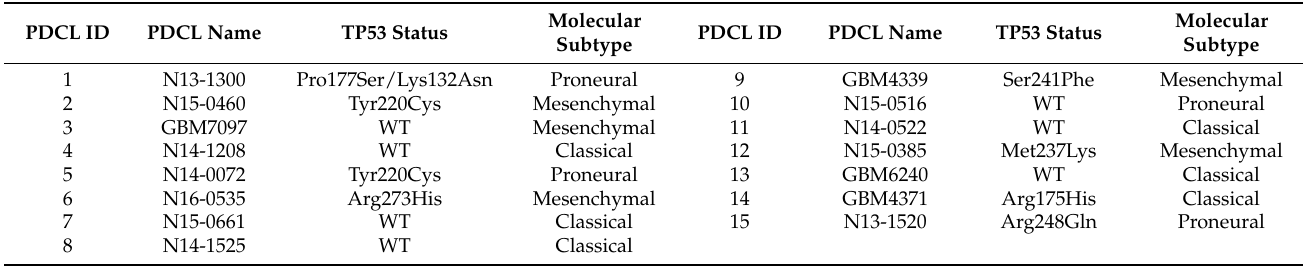
Table 1. List of PDCLs, their attributed ID number, TP53 gene status, and transcriptomic subtype according to the gene expression signature [11]. WT (wild